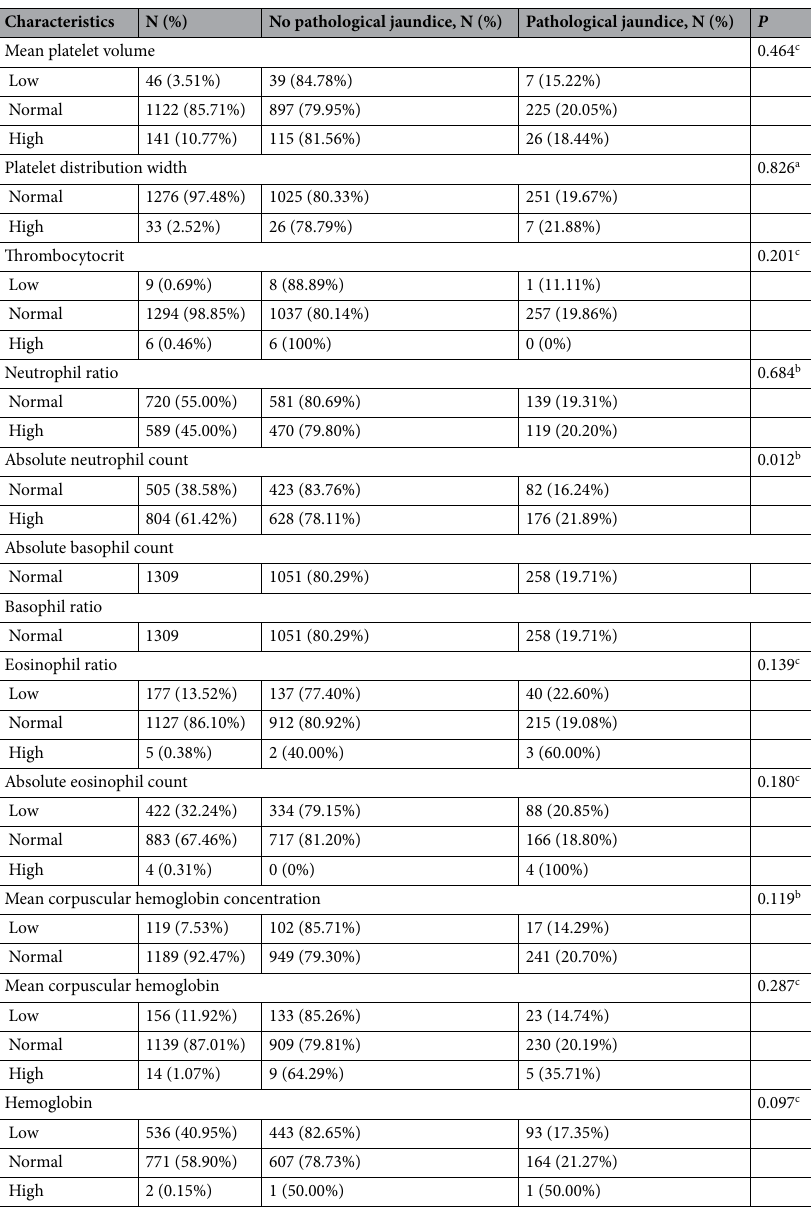
Table 1. Descriptive statistics and univariate analysis of maternal and neonatal with different characteristics. a P value was derived from the Fisher’s exact test. b P value was derived from the chi-square test. c P value was derived from the Wilcoxon rank sum